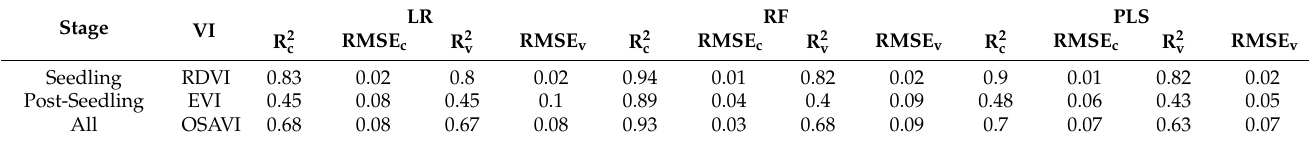
Figure 7. Pearson correlation coe ffi cient between vegetation indices and aboveground biomass. Table 4. Prediction results of LR, RF, and PLS with the optimal VI across all different growth stages.